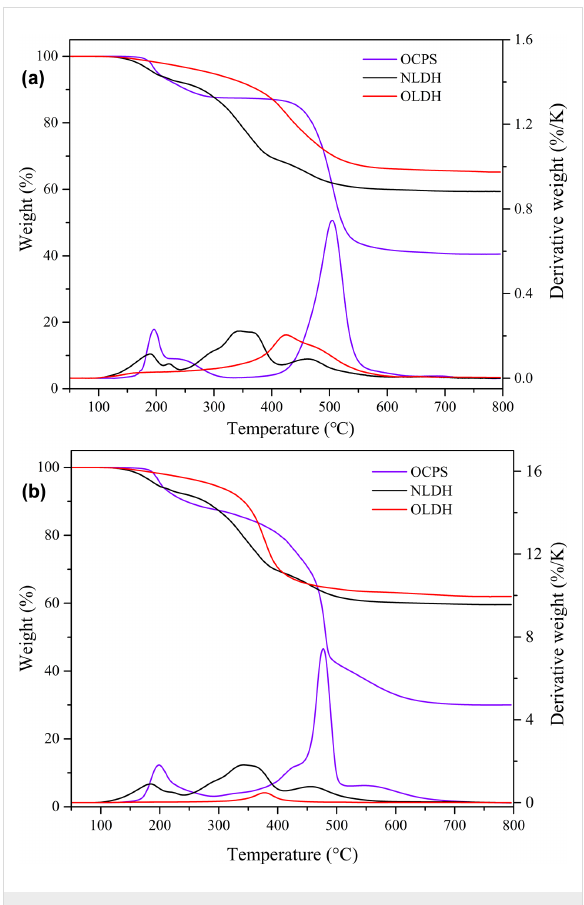
Figure 10: TG and DTG curves in (a) N 2 and (b)